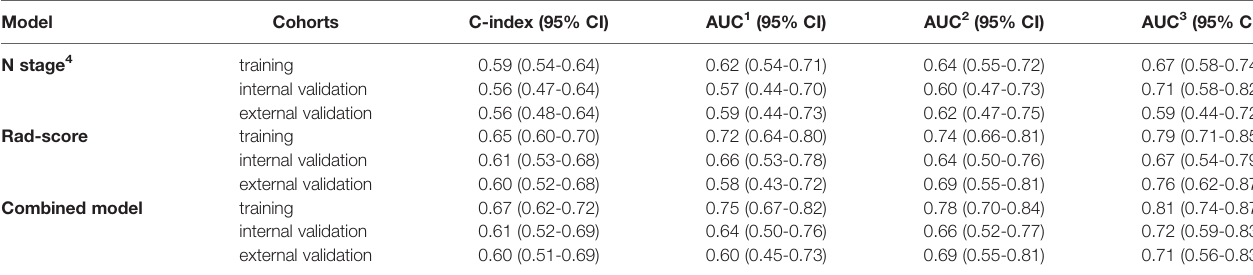
TABLE 2 | Model performance on predicting PFS and time-dependent PFS probability.